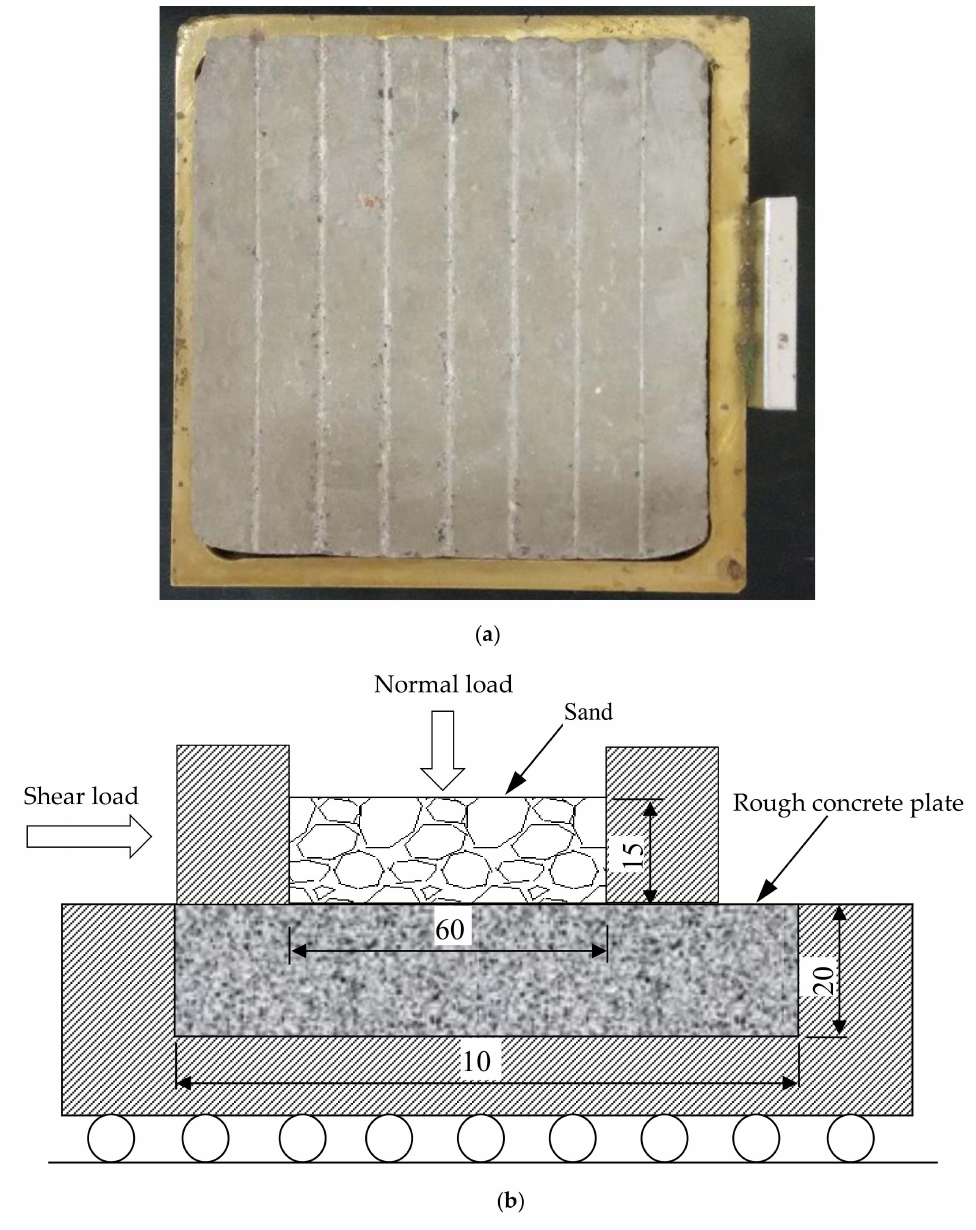
Figure 5. Modified test apparatus (unit: mm): ( a ) modified lower shear box; ( b ) schematic diagram of sand–concrete interface